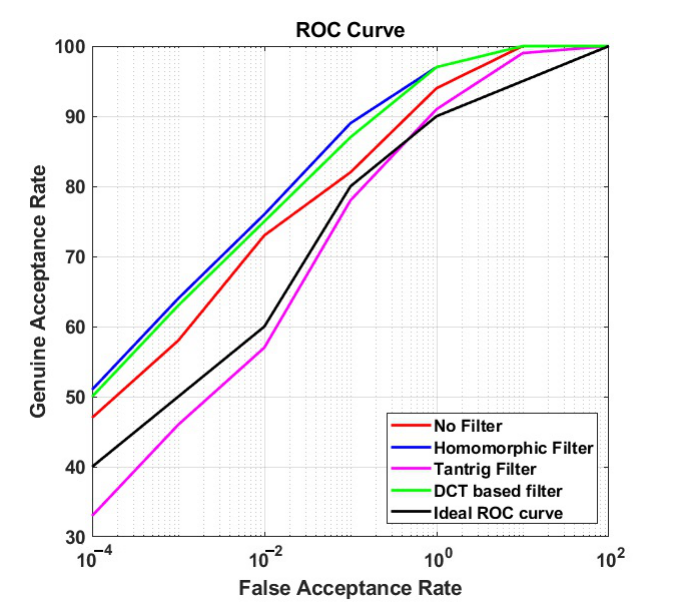
Figure 6. The ROC curves of the proposed method applied to CS face matching at a short distance (1 m) with the BLPOC frequency band